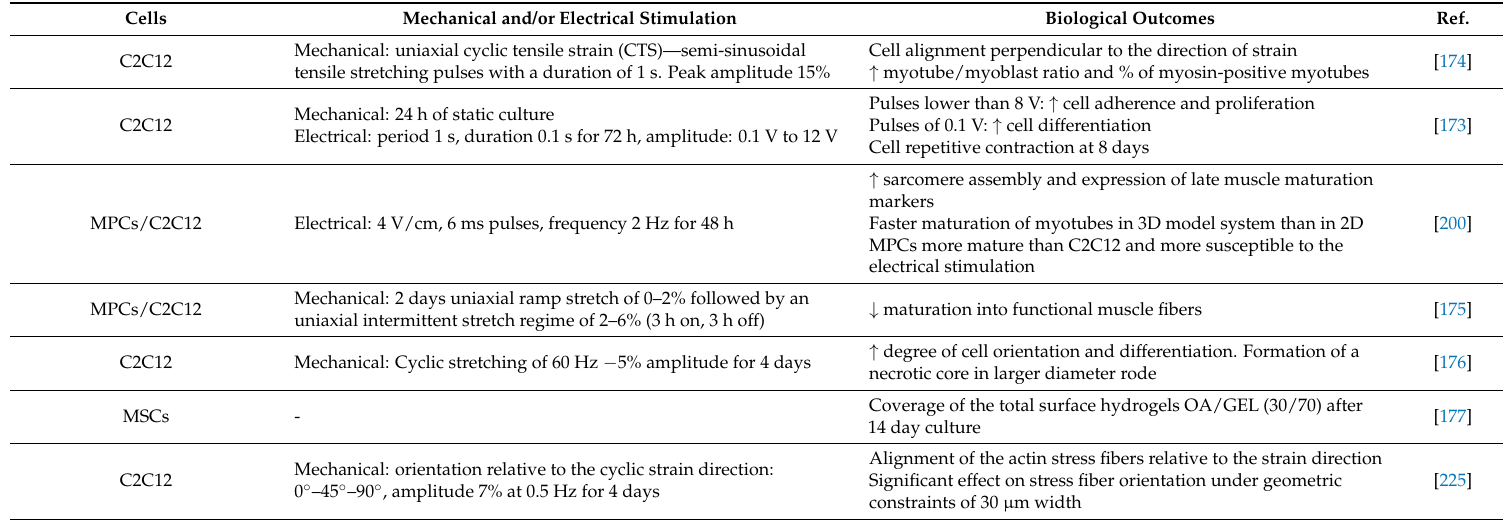
Table 5. In vitro performances of biohybrid construct in muscle tissue engineering ( ↑ = increase, ↓ =